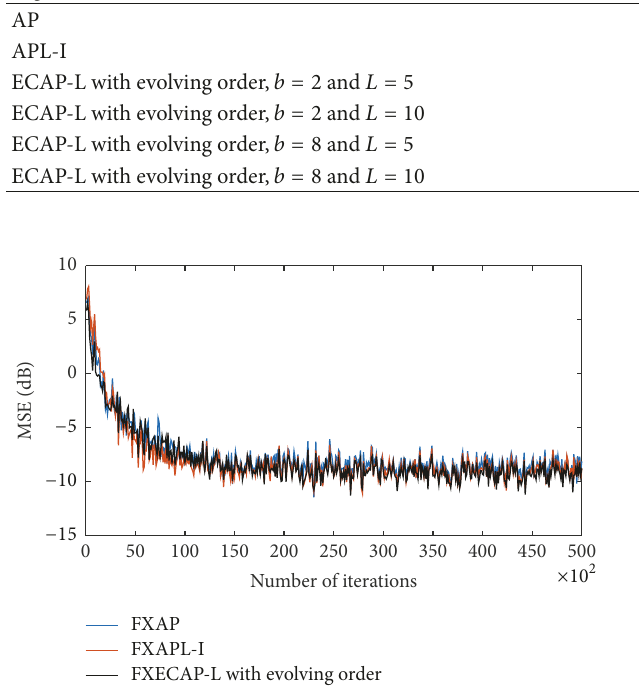
Figure 16: MSE values of the tested AP algorithms as measured at error sensor 1 for a projection order of 𝐿 = 10 when 𝑏 = 8 bits are used to encode the error.